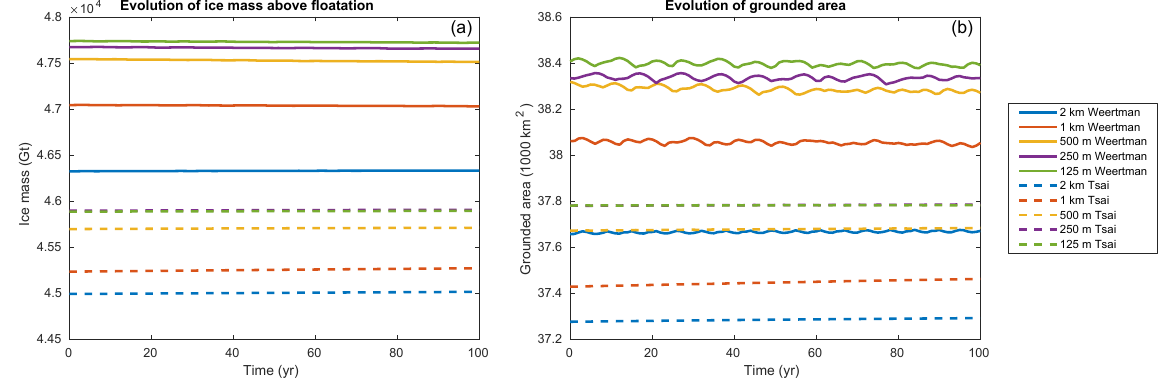
Figure 4. Evolution of ice volume above floatation (a) and grounded area (b) for experiment 0 (steady-state case with no melt applied). Solid and dashed lines represent simulations with Weertman and Tsai friction, respectively, for resolutions of 2km (blue), 1km (red), 500m (yellow), 250m (purple), and 125m (green). Results for 250 and 125m resolutions are superimposed for the Tsai friction.